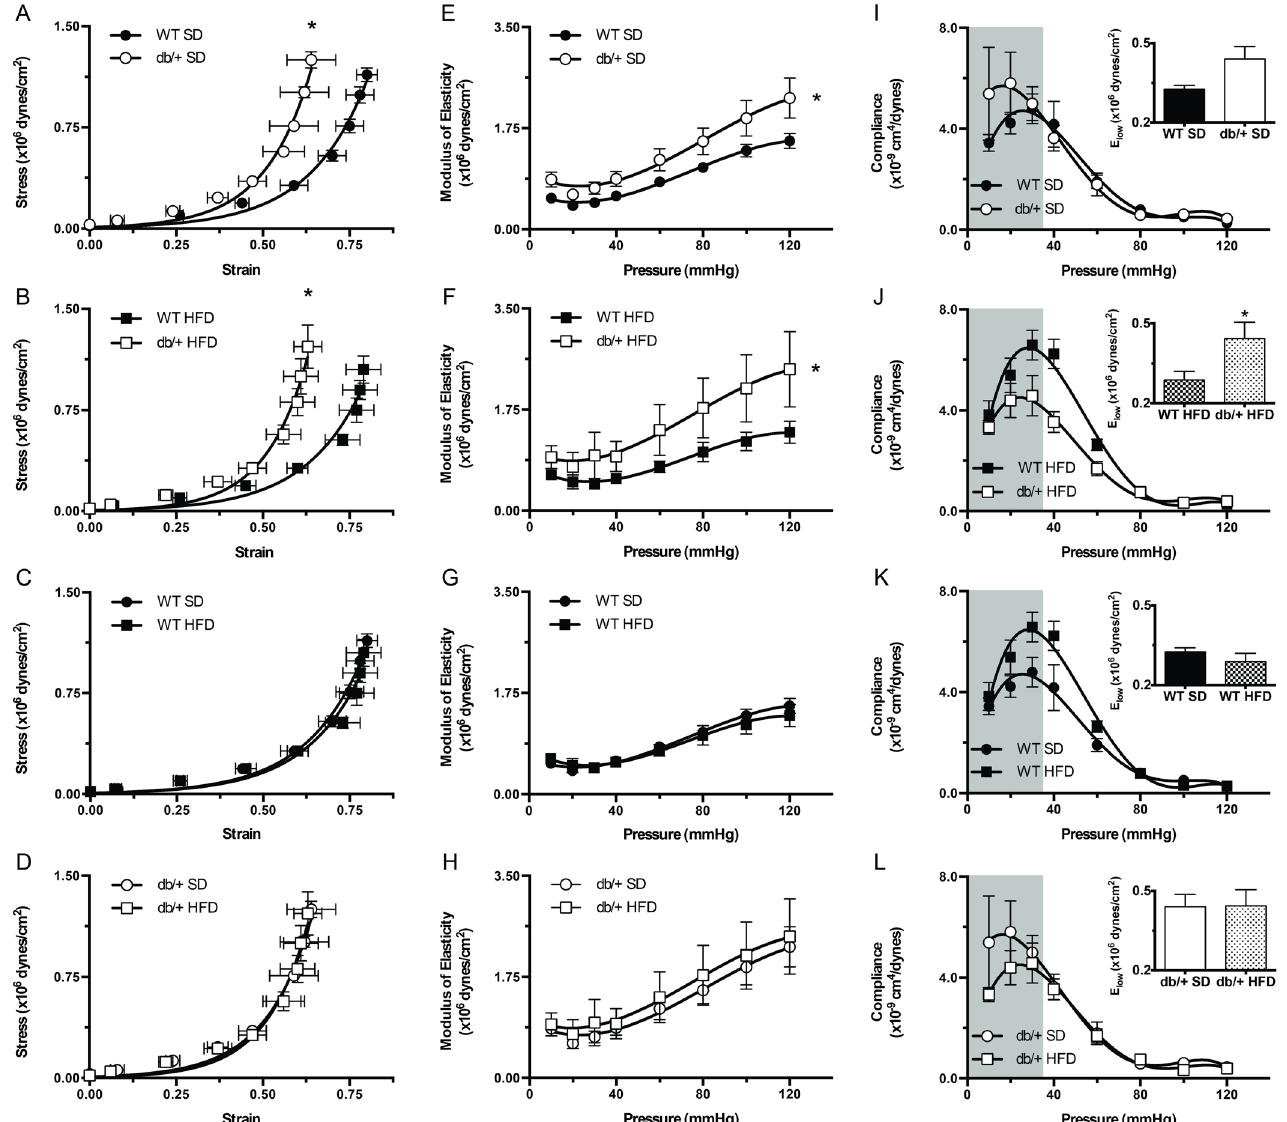
Fig 8. Effect of maternal environment and offspring diet on the mechanical properties of mesenteric resistance arteries from adult (31 week-old) wild type (WT) male offspring of WT-control or Lepr db/+ (db/+) dams. (A-D) Strain-stress relationship curves of mesenteric arteries kept under passive conditions at different intravascular pressures. (E-H) Elastic moduli of mesenteric arteries kept under passive conditions at different intravascular pressures. (I-L) Compliance of mesenteric arteries kept under passive conditions at different intravascular pressures. The shaded areas represent the data used to calculate the elastic moduli at low pressures, which are shown in the insets. Data are means ± SEM of n = 5 – 7 number of animals (vessels) per treatment group combination. * P < 0.05. SD, standard diet; HFD, high fat